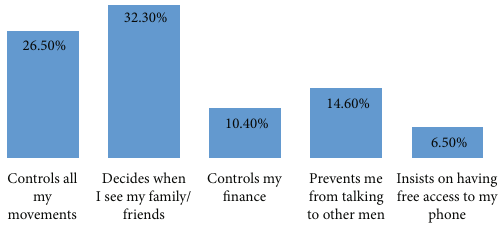
Figure 2: Controlling behavior of partner (multiple responses considered).